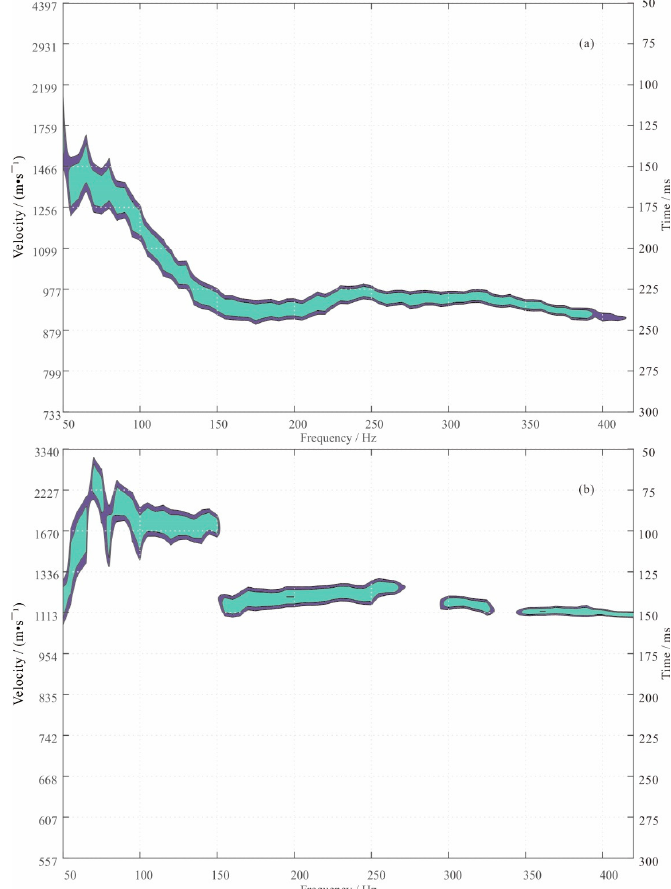
Figure 1. Dispersion curves: ( a ) continuous smooth dispersion curve and ( b ) irregular dispersion curve.